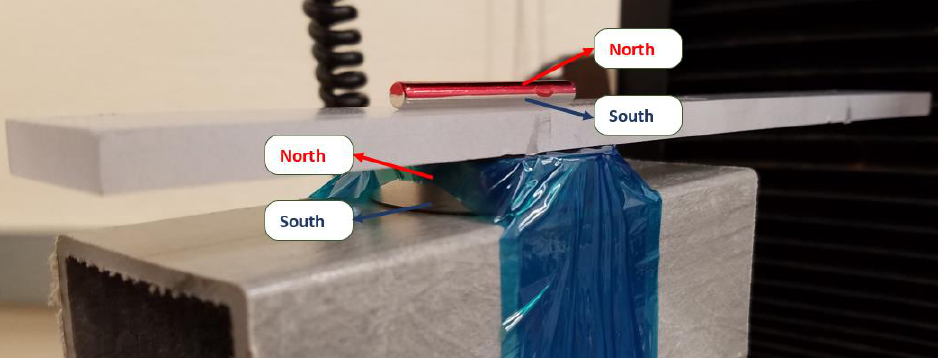
Figure 12. Marking the poles of the neodymium rod magnet so that when attached to the upper leg, the opposite poles face each other between the disk magnet and the rod magnet to ensure maximum attraction and no